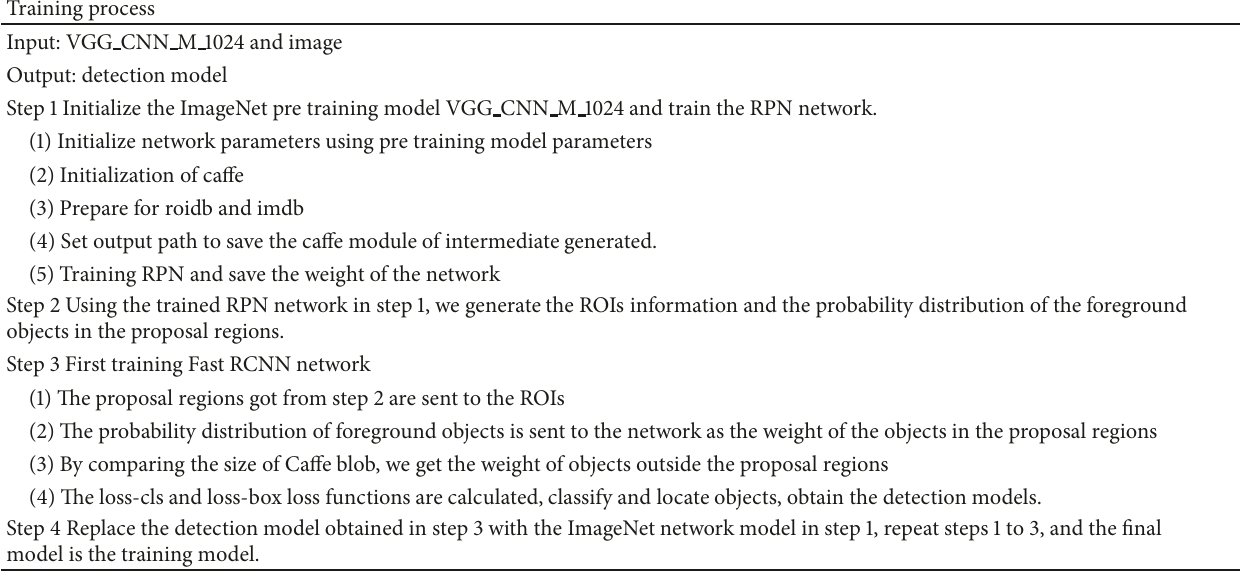
Table 1: The process of model